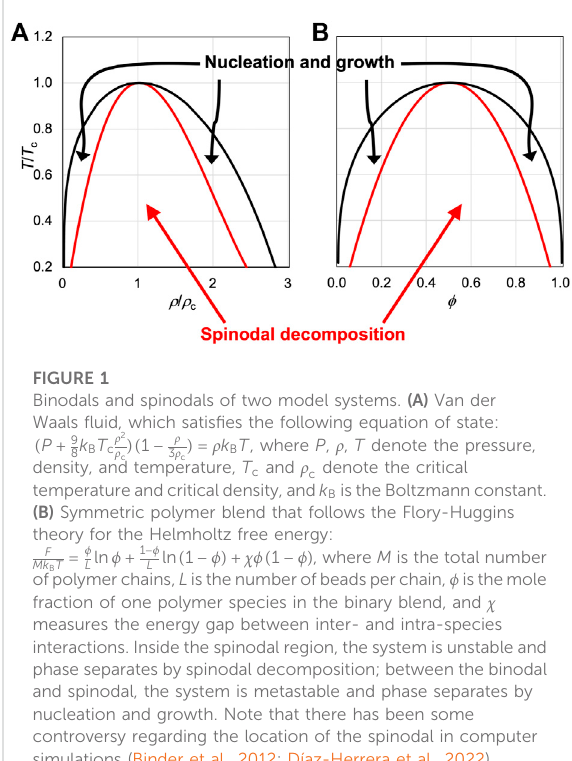
fraction of one polymer species in the binary blend, and χ measures the energy gap between inter- and intra-species interactions. Inside the spinodal region, the system is unstable and phase separates by spinodal decomposition; between the binodal and spinodal, the system is metastable and phase separates by nucleation and growth. Note that there has been some controversy regarding the location of the spinodal in computer simulations (Binder et al., 2012; Díaz-Herrera et al.,